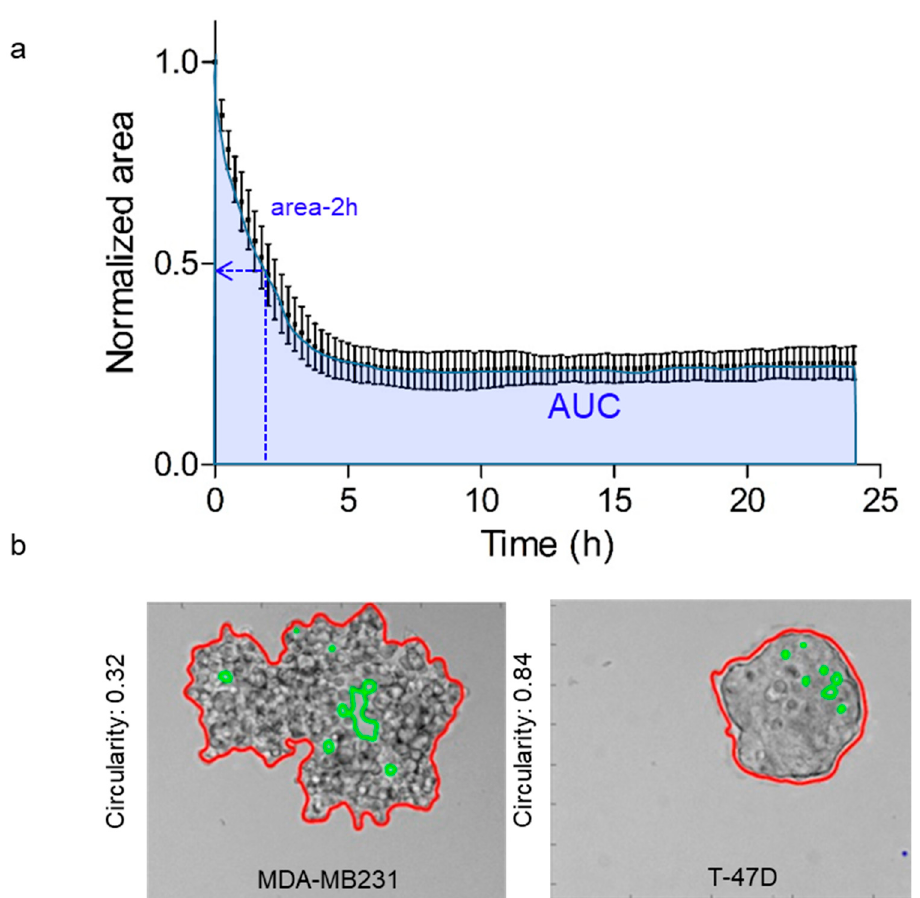
Figure 1. Determination of the quantitative parameters of anchorage-independent cancer cell aggre- gation dynamics. (a) Definition of the parameters extracted from the average aggregation curves of the normalized area. Each value of the normalized area, measured every 15 min, is the mean of 3–5 independent experiments with error bars. The area-2h is the area at 2 h and AUC is the area under the curve. (b) Micrographs : determination of the aggregate circularity after 24 h using an automated image analysis procedure. The red line shows the contours of the aggregate and the green color marks areas without cells. MDA-MB-231 (left) and T-47D (right) cells are shown as examples of circularity variations after 24 h. The circularity values are indicated on the side of the micrographs.